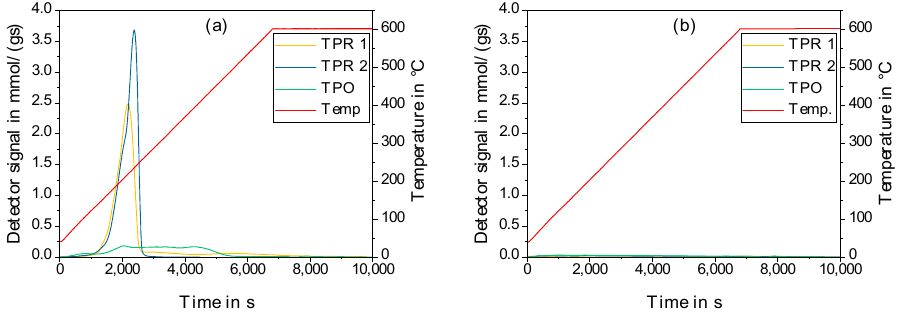
Figure 9. Results of TPROR measurements up to 600 °C: ( a ) Copper-silica system with a maximum of the second TPR at about 235 °C. ( b ) Silver-silica system without detectable signals due to thermal decay of Ag 2 O from approx. 230 °C.